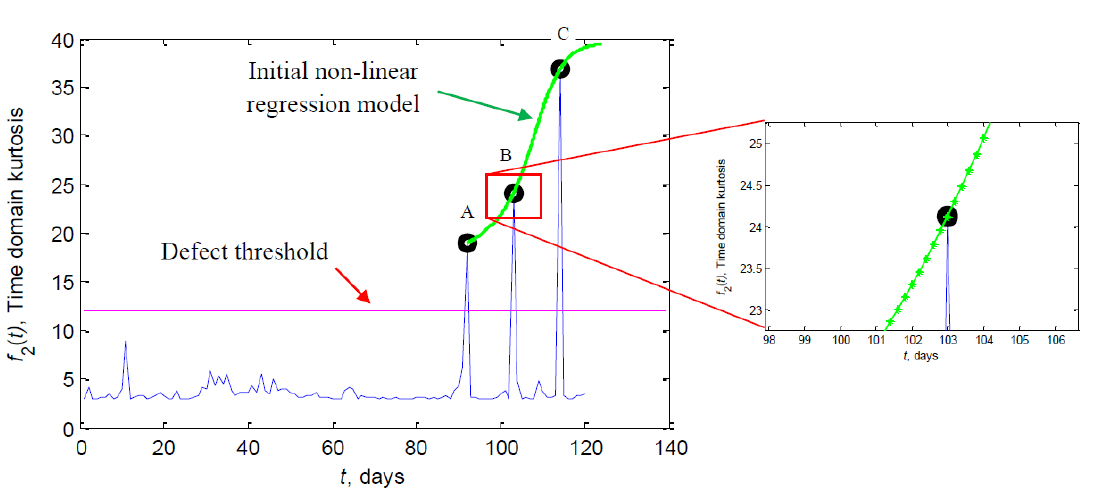
Figure 5. Regression model of three data points and one-step-ahead prediction. Table 3. Kernel regression model for 1 step-ahead prediction of time-domain kurtosis.